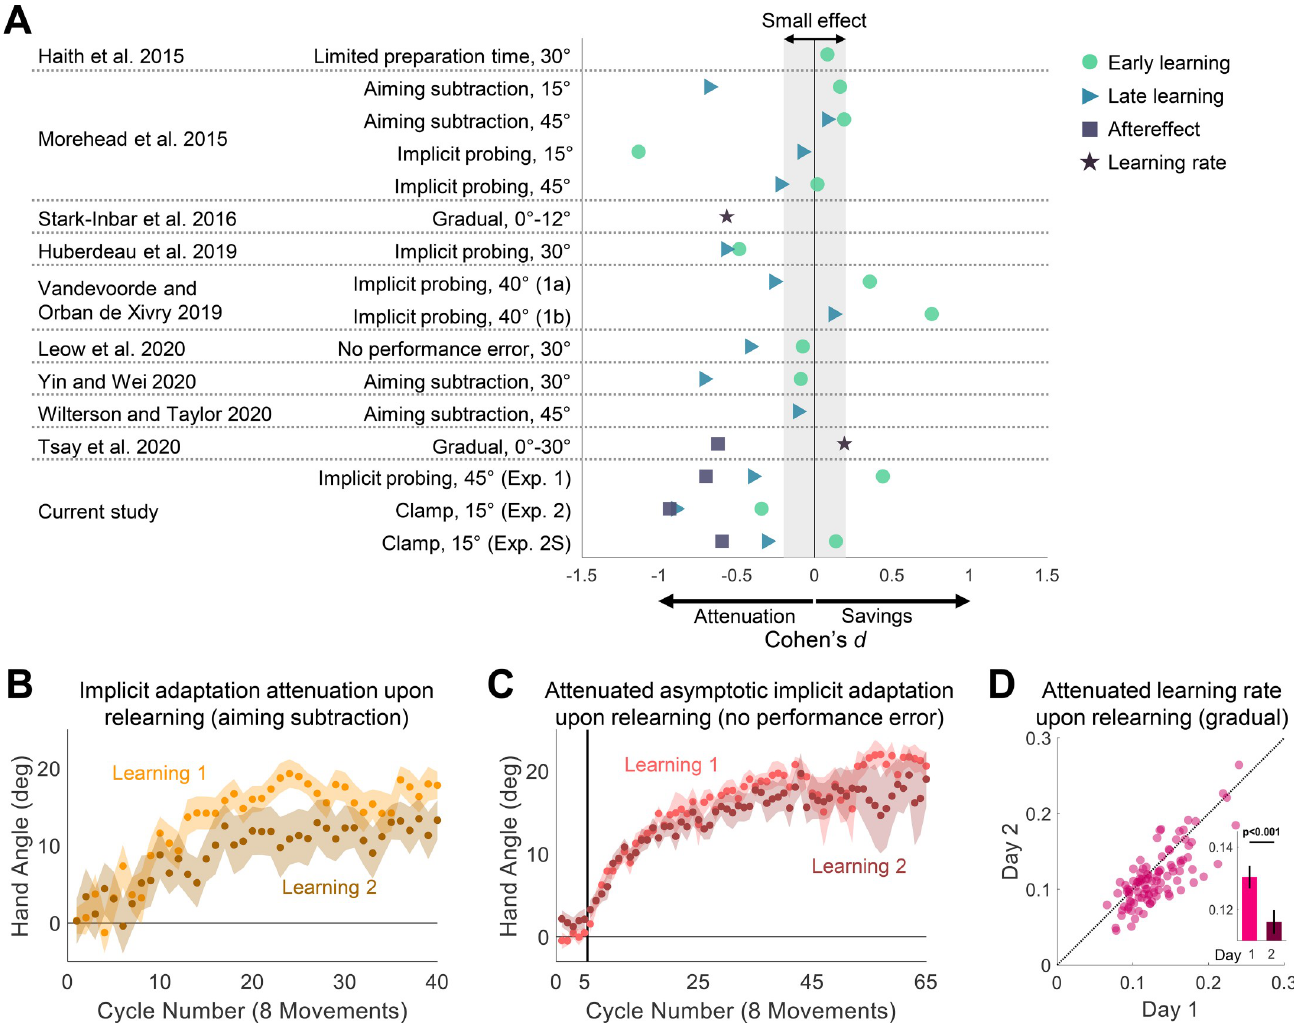
Fig 3. Prior evidence for attenuation upon relearning for implicit visuomotor adaptation. ( A ) Cohen’s d effect size of the differences in learning measures between the second and first learning blocks for experiments meeting our criterion for inclusion in the review of the literature. Early learning (green circles), Late learning (blue triangles), Aftereffect (purple squares), and Learning rate (dark purple stars). ( B, C ) Overlaid hand angle functions of implicit adaptation to a visuomotor rotation over 2 learning blocks. Light and dark colors denote blocks 1 and 2 of the experiment, respectively. Shaded margins represent the SEM. In B , implicit adaptation was extracted by subtracting a reported aiming location from movement hand angle on every trial. Adapted with permission from Yin and Wei (2020). In C , implicit adaptive response to the rotated cursor when the target jumps in a manner that eliminates task error. Adapted with permission from Leow et al. (2020). ( D ) Learning rate during adaptation to a gradually changing visuomotor rotation, tested on 2 days. Pink markers represent individual participants. Black diagonal dotted line represents the unity line. Bars and black vertical lines (inset) represent mean and SEM, respectively. Adapted with permission from Stark-Inbar et al. (2016). The individual data and the summary statistics presented in this figure can be found in S1 Data. SEM, standard error of the mean.